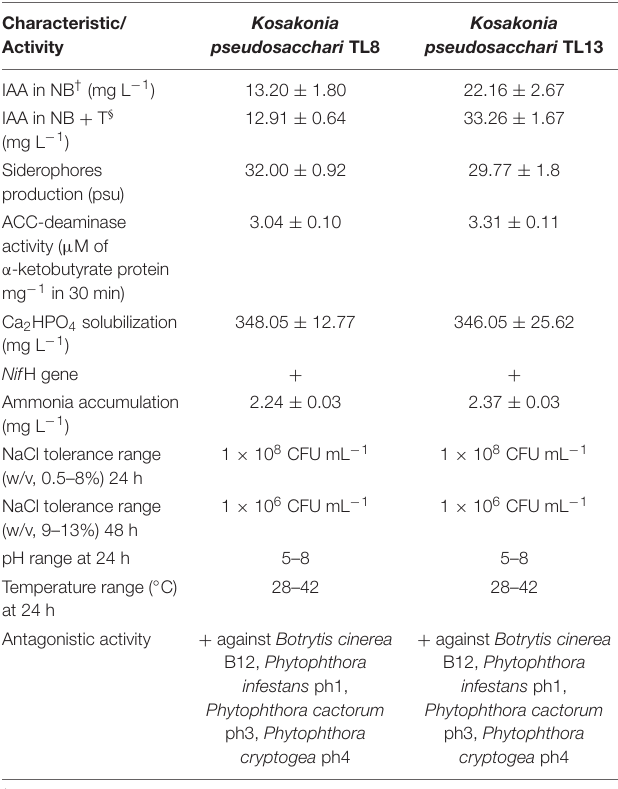
TABLE 2 | Differential phenotypic characteristics and plant growth-promoting traits of bacterial strains Kosakonia pseudosacchari TL8 and TL13. Characteristic/